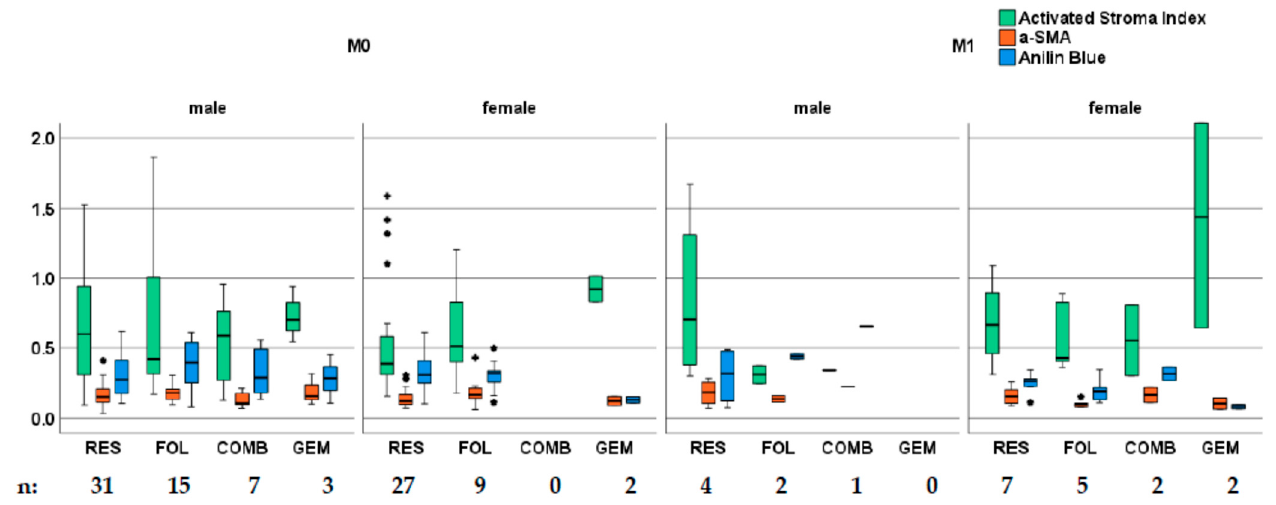
Figure A1. Overview of tissue parameter distribution across subgroups of NT, M status and sex with annotated group sizes. Female patients were more frequent in the M1 subgroup and underrepresented in the COMB subgroup; all male GEM patients were also M0. Asterisks indicate outlier values (>1.5× IQR), + indicates extreme outliers (>3× IQR).